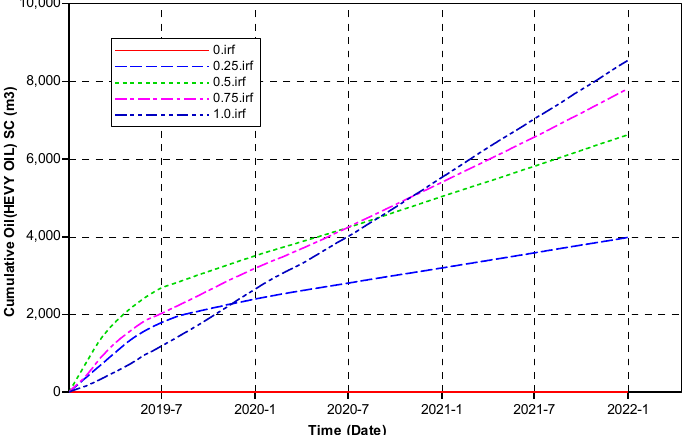
Figure 7. Cumulative oil production after steam flooding at different proportion of components.